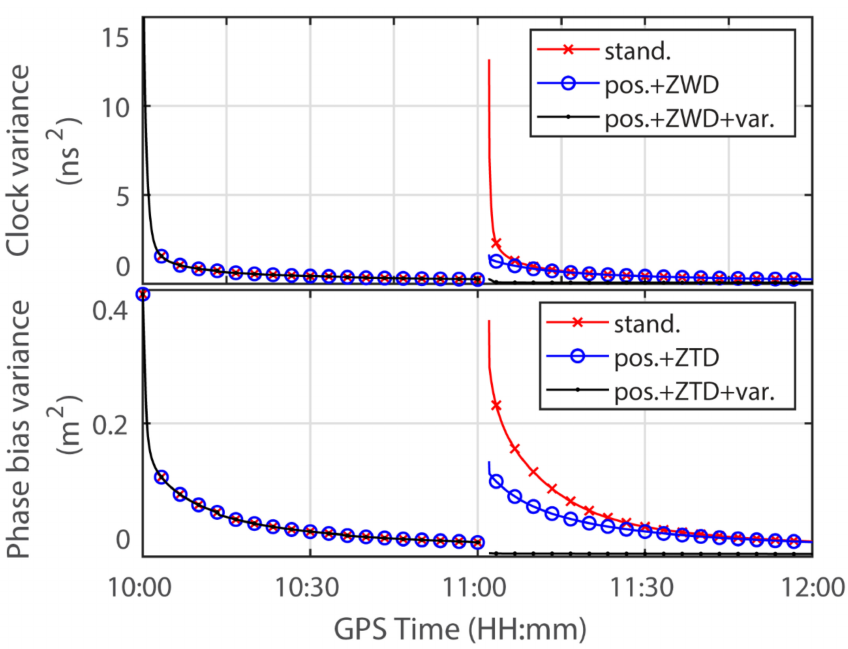
Figure 7. Variance time series for the receiver clock offset and GPS PRN 11 phase bias estimations from the standard PPP (red line with cross marks), position- and ZWD-constrained PPP with initialized variance (blue line with cycle marks) and position- and ZWD-constrained PPP with inherited variance from prior estimations before the gap (black line with solid dots).